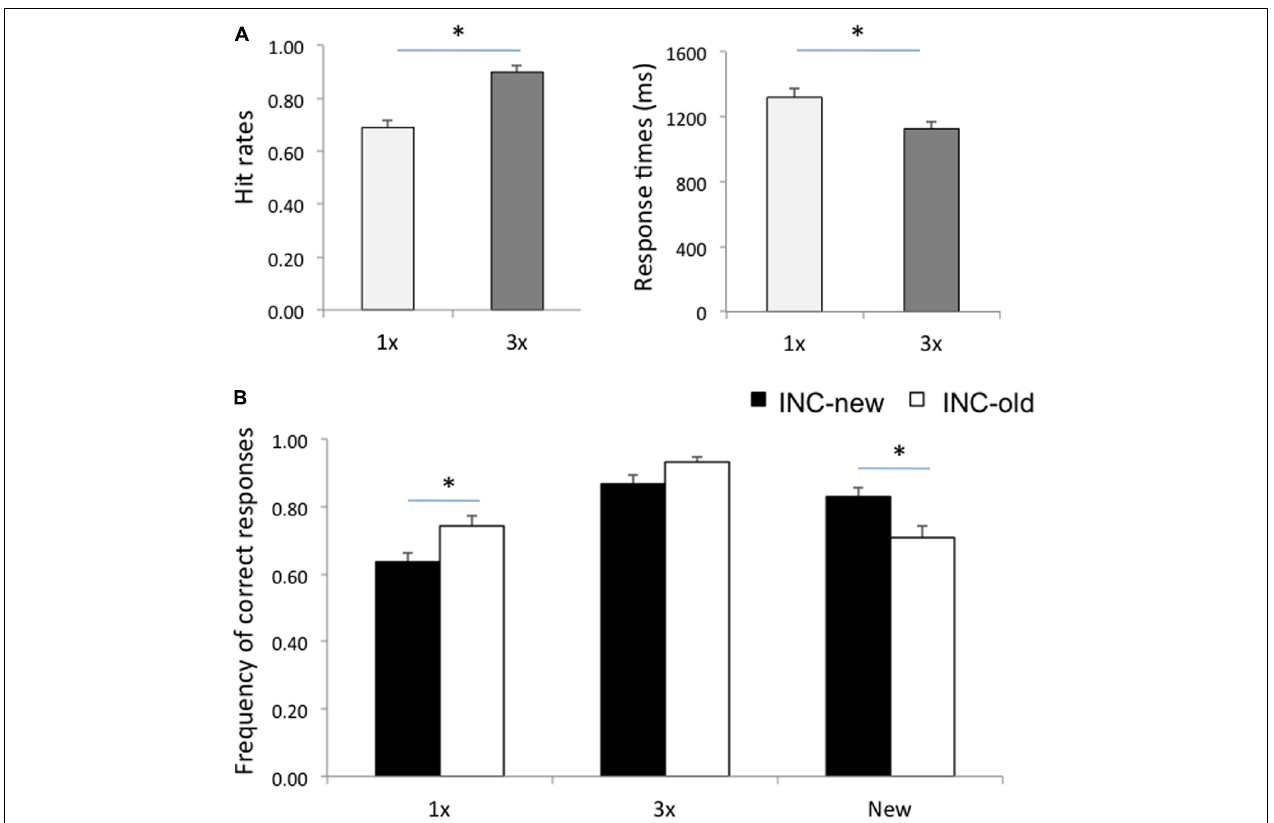
FIGURE 1 | (A) Hit rates and response times for items studied once (1x) and for items studied three times (3x). (B) Frequency of correct responses for 1x, 3x, and new items in the Incentive-old (INC-old) and in the Incentive-new (INC-new) conditions. Error bars represent standard errors of the mean. Asterisks denote a significant difference ( p <